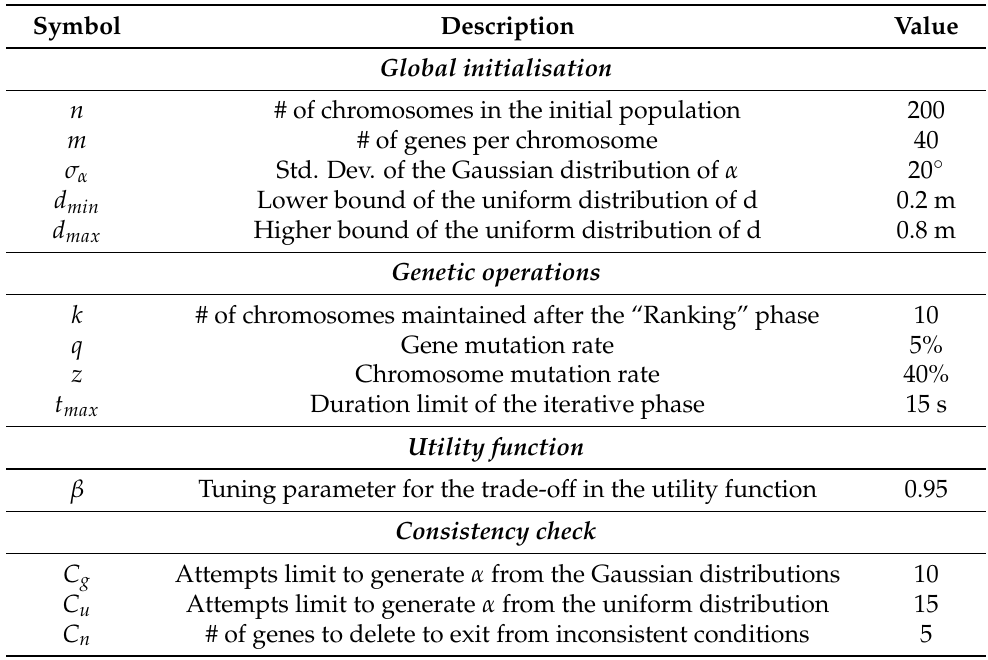
Table 1. Summary table of the GPP parameters value utilised within this